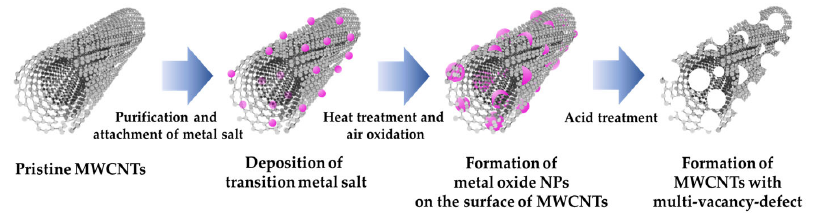
Figure 2. Schematic diagram of the entire experimental